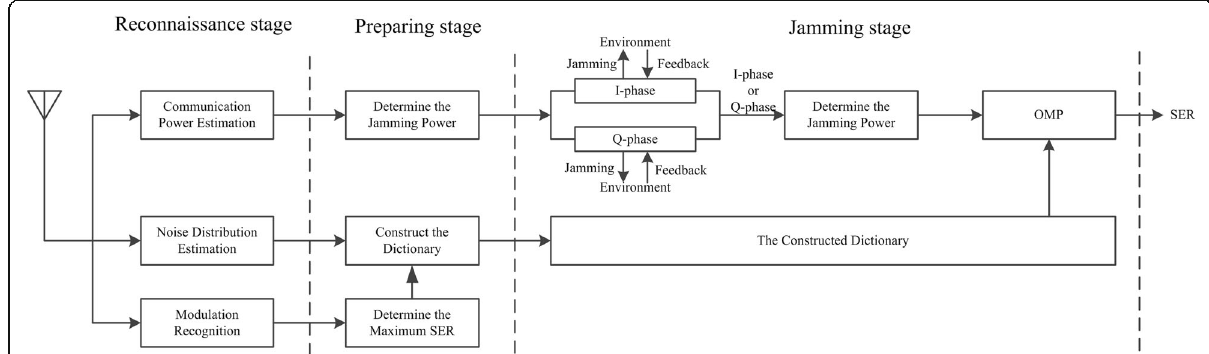
Fig. 3 Schematic diagram of the proposed jamming algorithm. Additional details about the process of the proposed jamming algorithm are shown in the schematic diagram. The dictionary is constructed with reconnaissance result, and the sampled data in OMP is the feedback from the